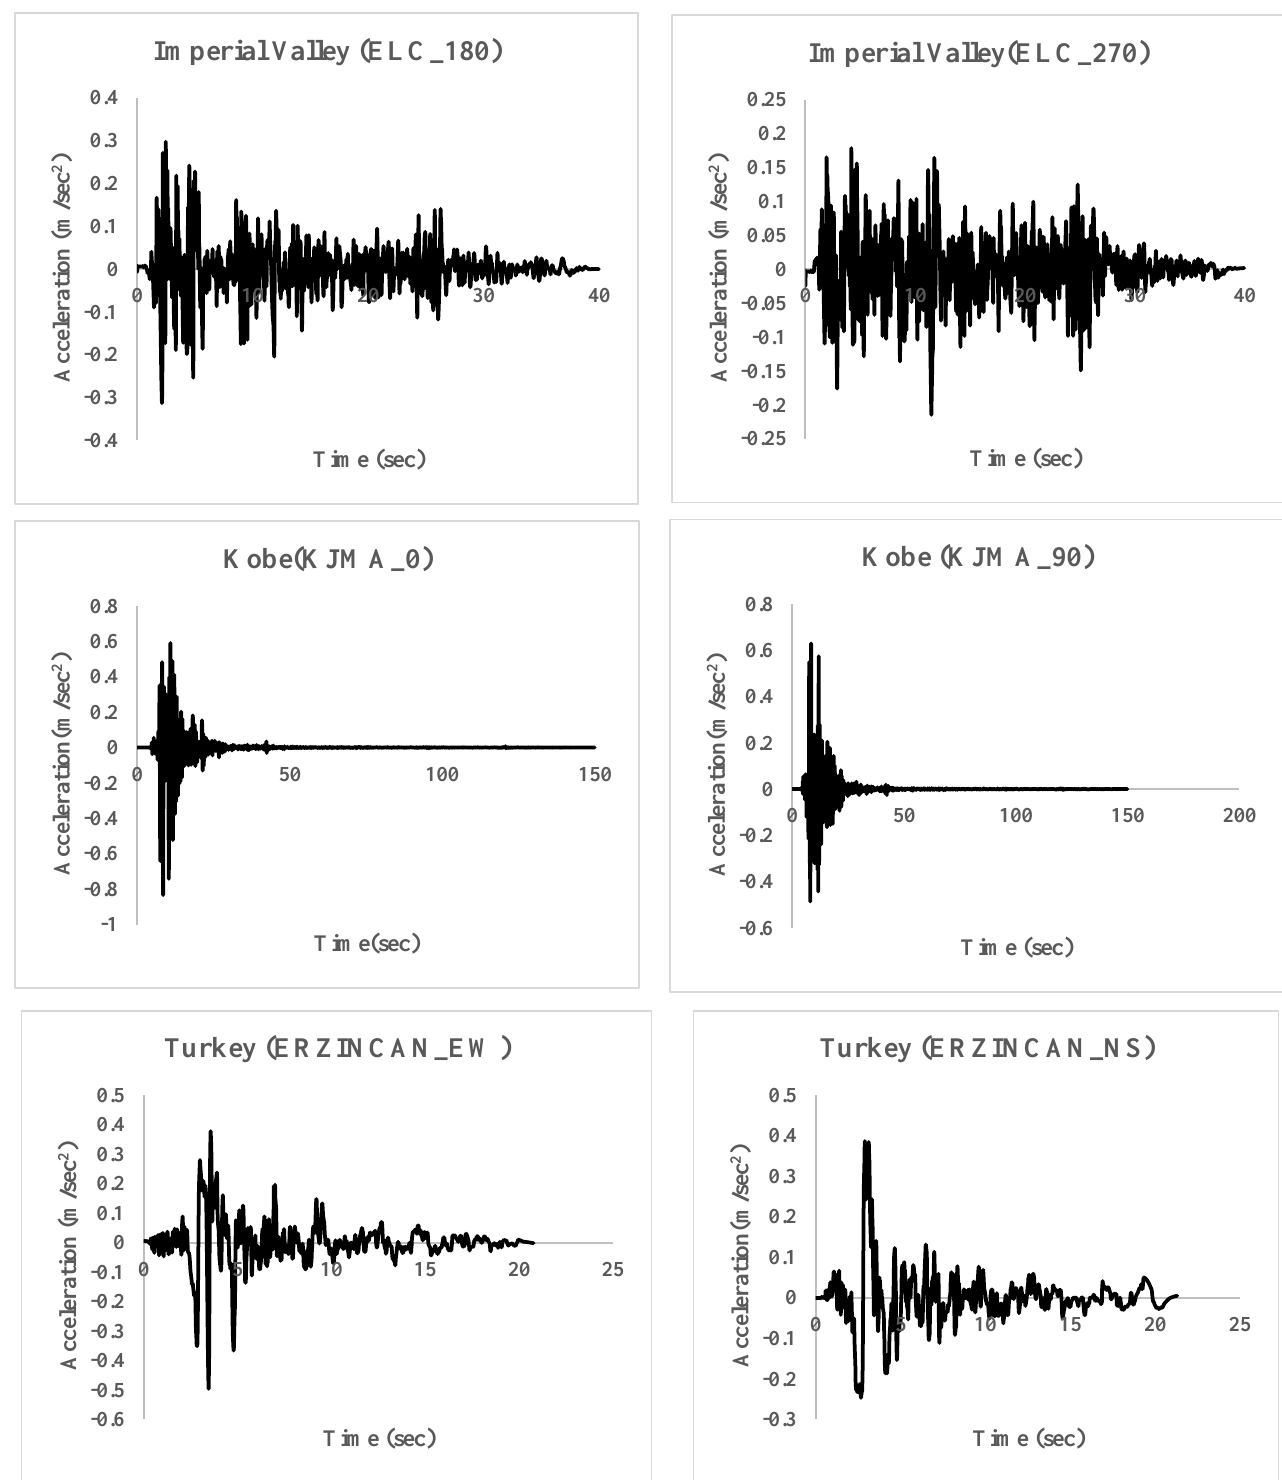
Figure 5. Selected recorded earthquake motion time histories .